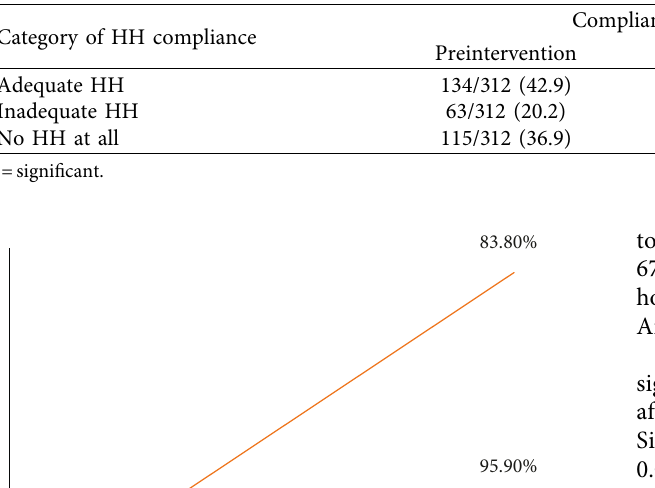
Table 5: Changes in adequacy in HH action after intervention.